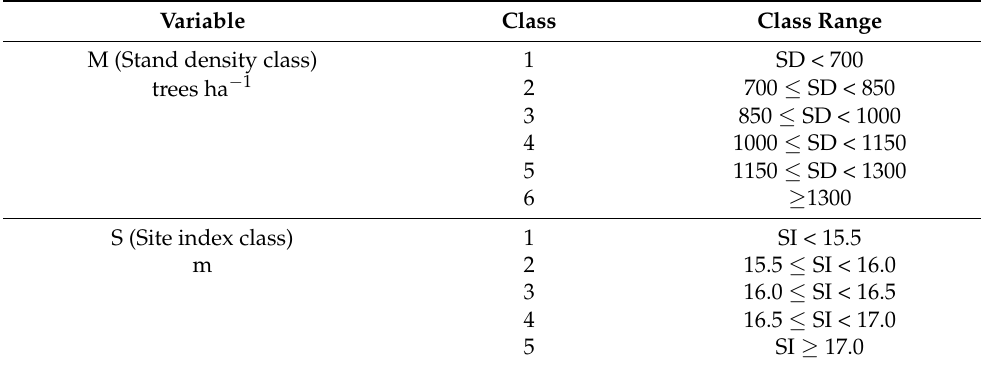
Figure 2. Total tree height plotted against diameter at breast height. Table 3. Range of stand density class and site index class for Larix olgensis . SD is stand density; SI is site